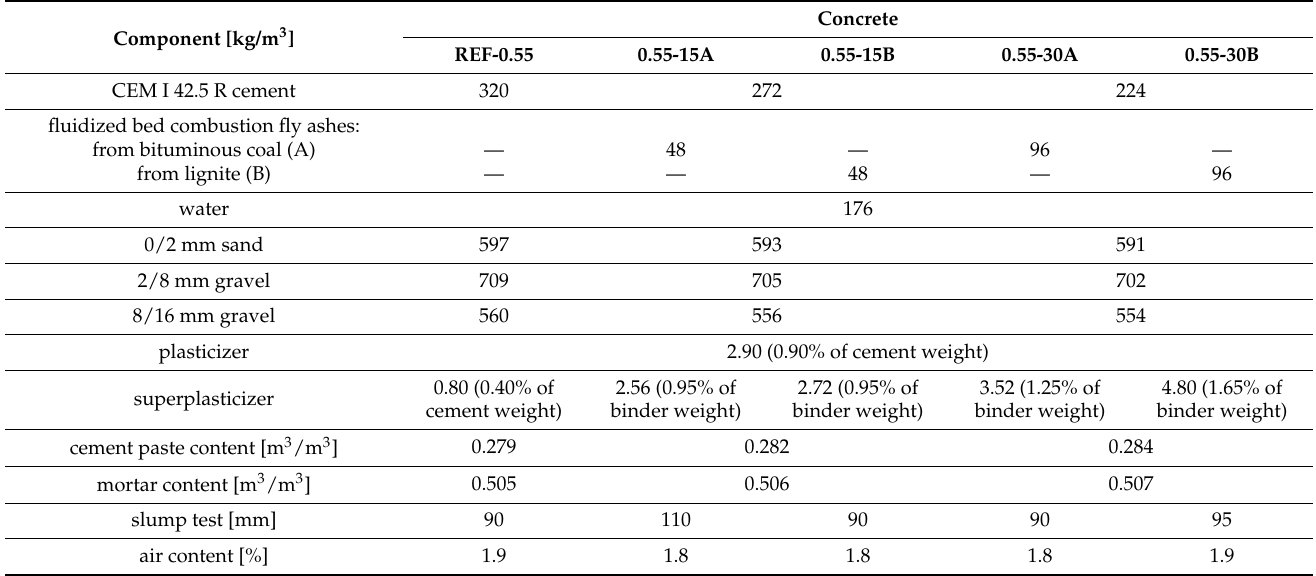
Table 6. Composition of concretes with w / b ratio = 0.55 without and with fluidized bed combustion fly